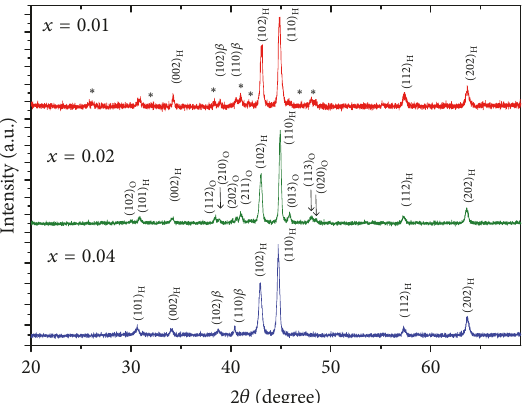
Figure 1: Room temperature XRD patterns of MnCo 1−𝑥 Zr 𝑥 Ge compounds with 0.01 ≤ 𝑥 ≤ 0.04. The orthorhombic and hexagonal peaks are indexed with hkl Miller indices with “O” and “H,” respectively. The peaks indicated by “ ∗ ” are unknown phase. The peaks labeled with hkl Miller indices with the symbol “ 𝛽 ” are from the 𝐾 𝛽 wavelength, from the X-ray source.